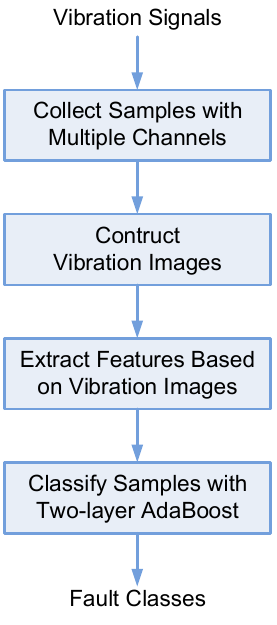
Figure 1. Flowchart of the proposed algorithm.